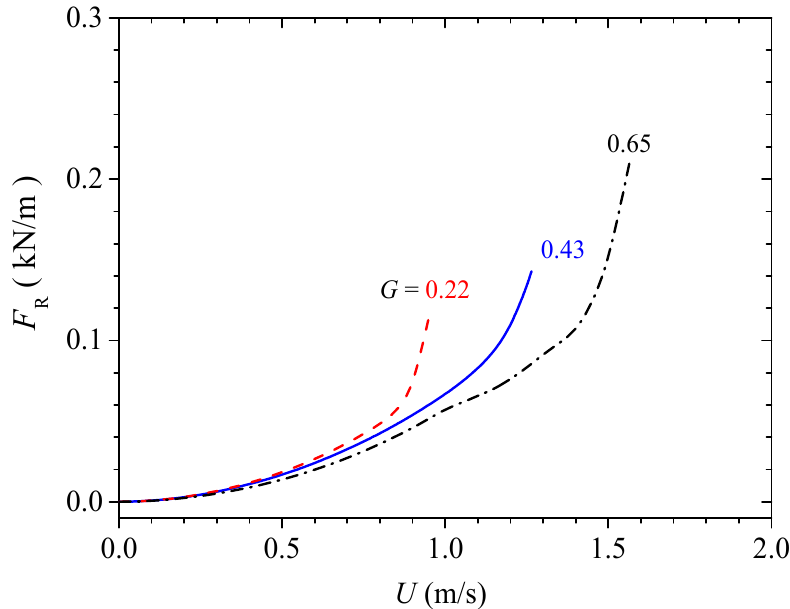
Figure 12. Variations of the lateral soil resistance to the pipe ( F R ) with the flow velocity ( U ) for various values of the submerged weight of the pipe ( G ) ( e/D = 0.10).